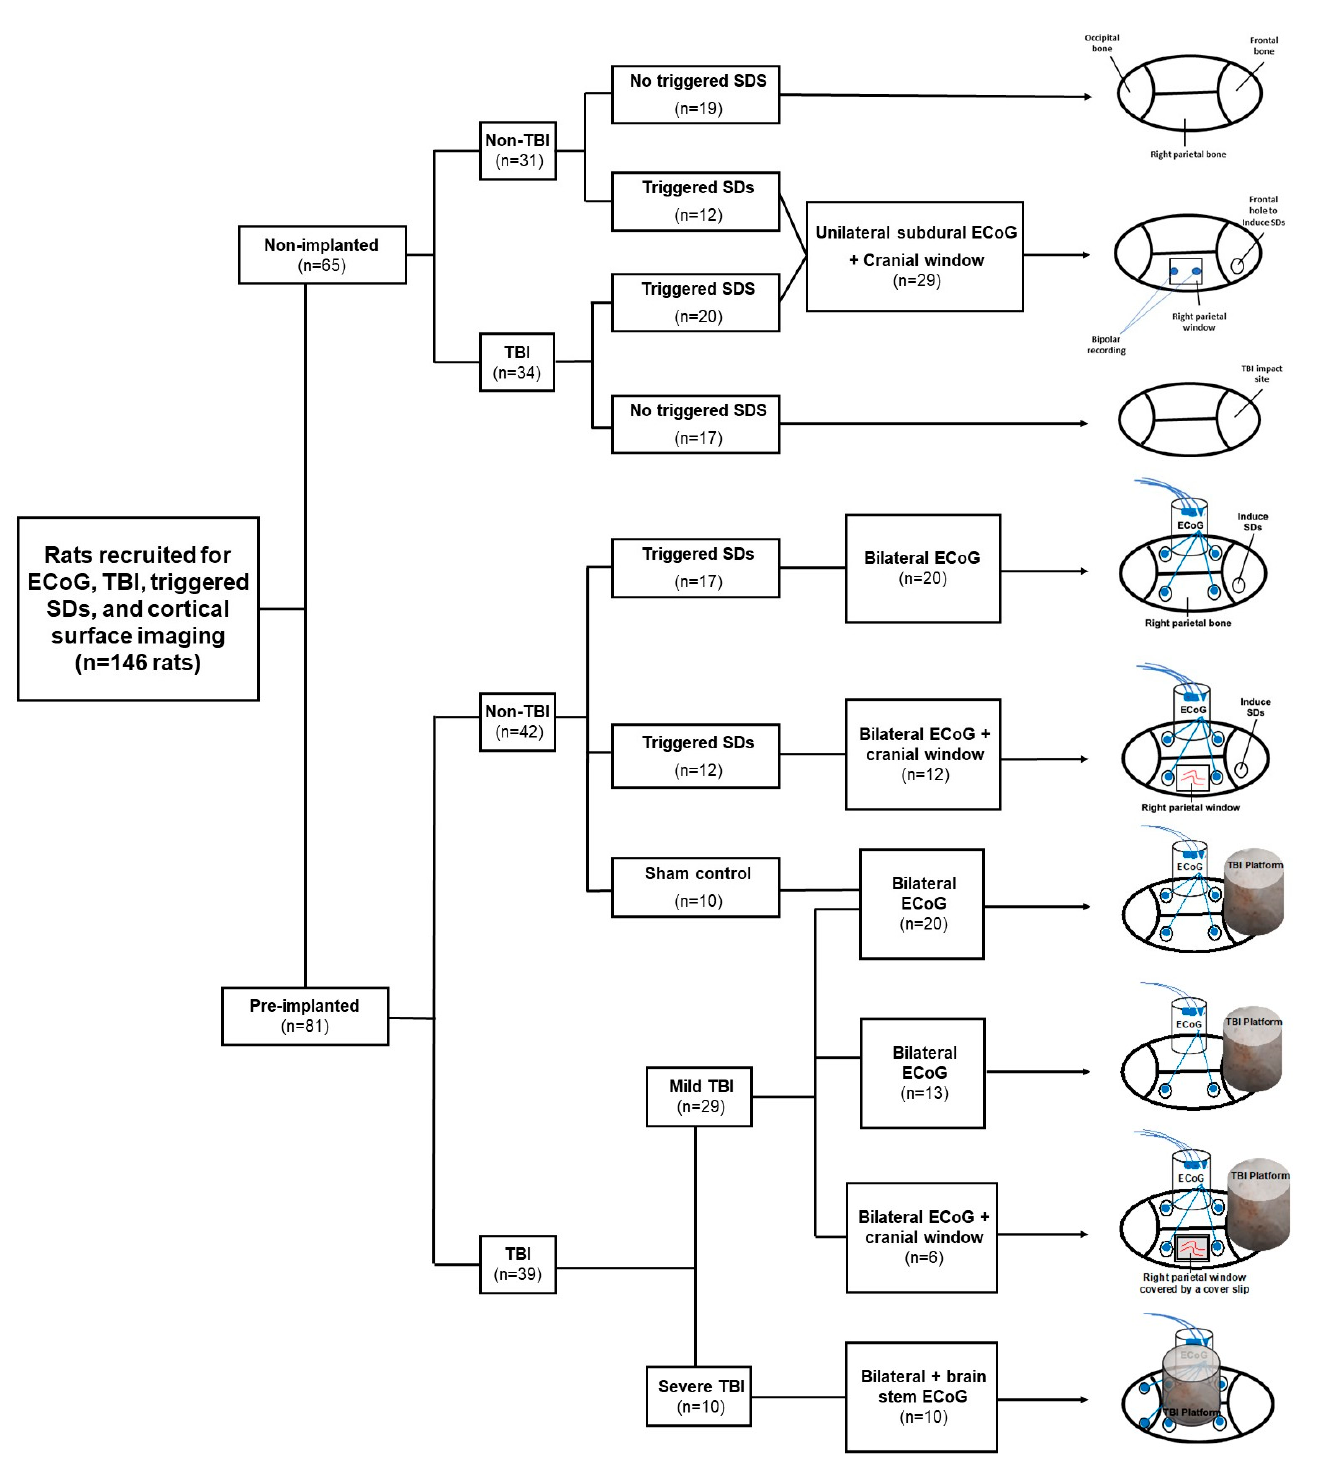
Figure 4. Flowchart of the study design. Schematic drawings show the location of ECoG recording and electrically triggering SDs, right parietal window for cortical monitoring, and constructed platforms for TBI.